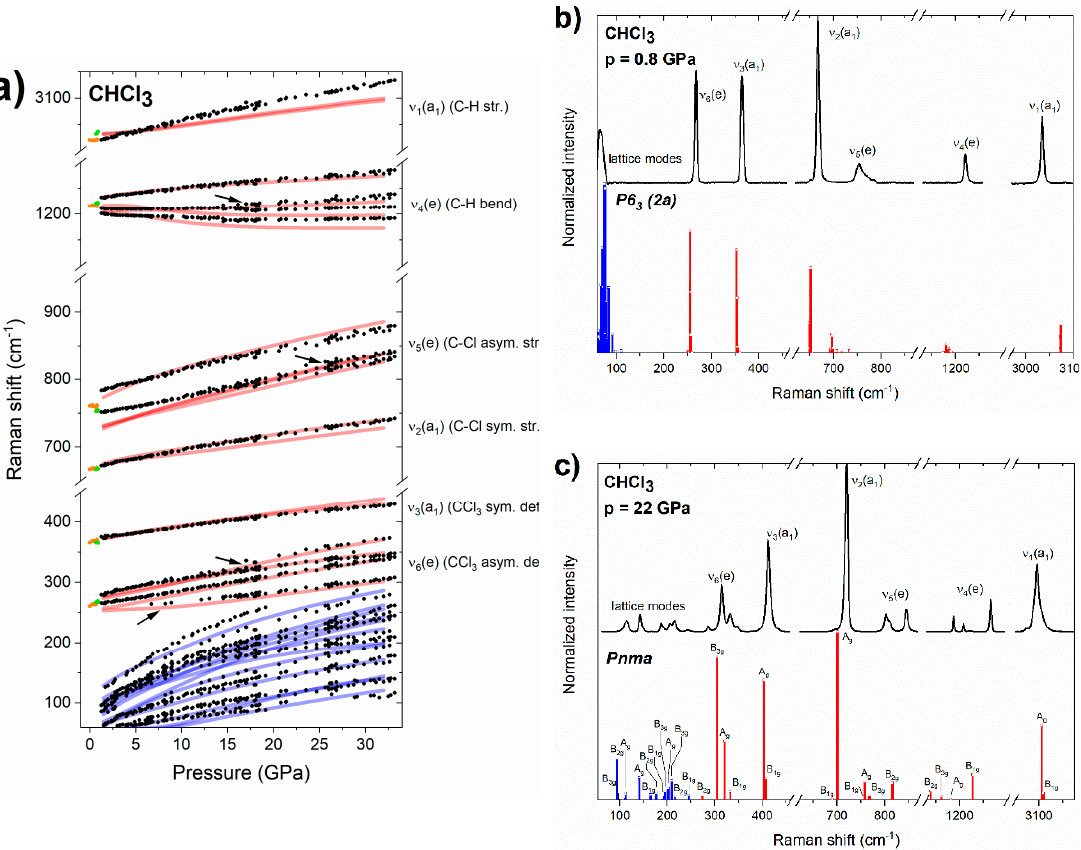
Figure 2. ( a ) Pressure dependence of the experimental frequencies of Raman bands of liquid (orange dots) and solid (green / black dots for P6 3 / Pnma ) chloroform. Arrows indicate new bands appearing upon compression of the Pnma structure. Blue / red lines mark the simulated frequencies for lattice / internal Raman-active modes of the Pnma structure. For ease of comparison, the theoretical frequencies were scaled by 1.03 (with the exception of the ν 1 / ν 5 modes which were scaled by 0.99 / 1.05). ( b ) Experimental Raman spectrum of solid chloroform at 0.8 GPa, together with Raman intensities simulated for the P6 3 (2a) structure (blue / red bars for lattice / internal modes, all of them of A symmetry). ( c ) Experimental Raman spectrum of solid chloroform at 22 GPa together with Raman intensities simulated for the Pnma structure (blue / red bars for lattice / internal modes, symmetry labels are given).